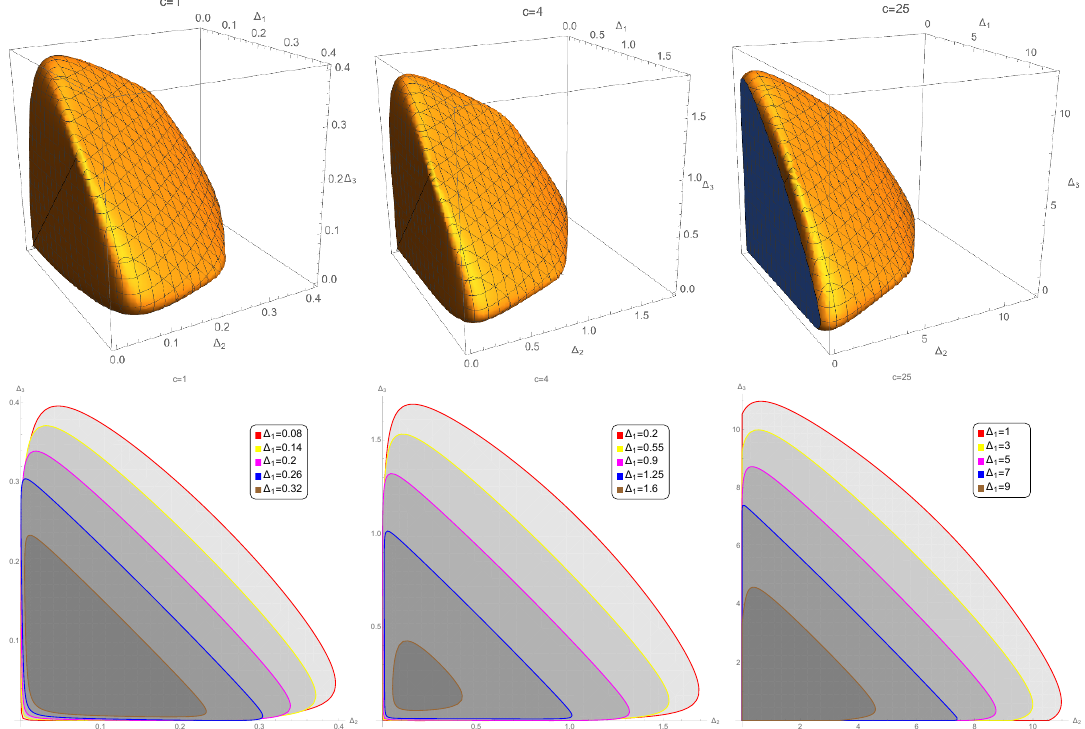
Figure 6 . Top : three-dimensional plots of the domain D (3) cross-sections of these domains for various values of (cid:1) 1 .